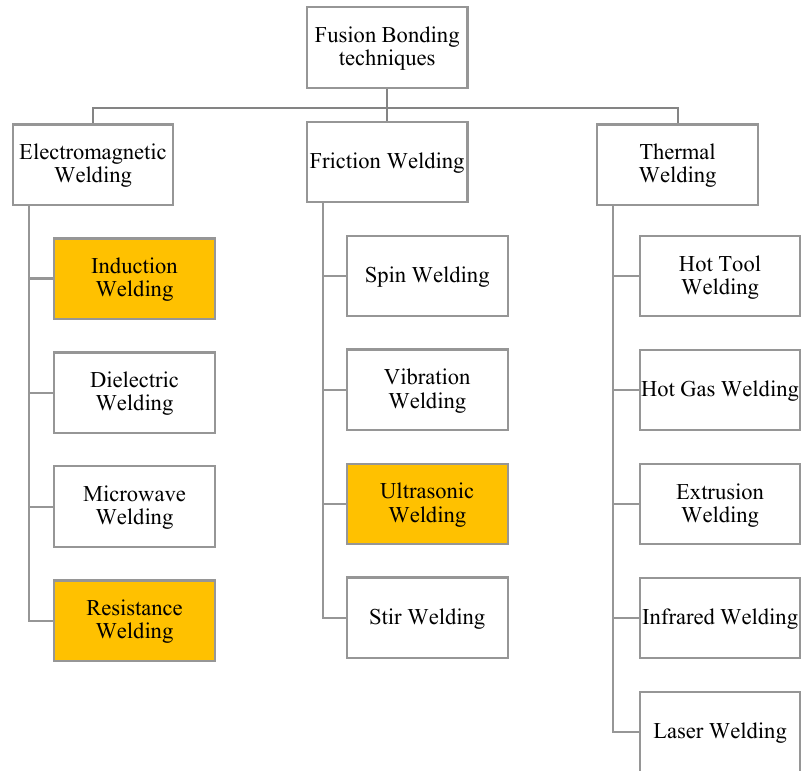
Figure 1. Fusion bonding techniques categorized by the technology used to generate heat. The main fusion bonding techniques are highlighted in yellow. Materials 2020 , 13 , x FOR PEER REVIEW